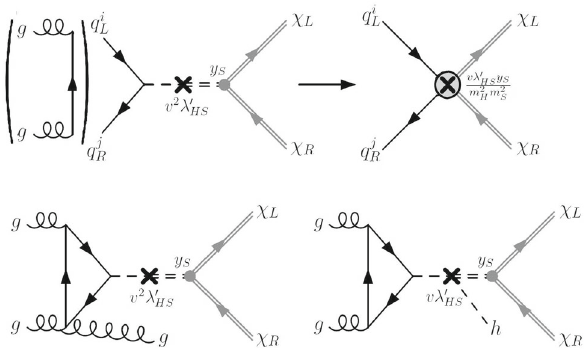
Fig. 3 Relevant diagrams contributing to nuclear interaction with fermionic DM (first row) and corresponding DM observables at hadron colliders (monojet and Higgs + / E T , second row), turning on the inter- actions ∼ λ (cid:3) and ∼ y S . Note that the corresponding diagrams are not HS